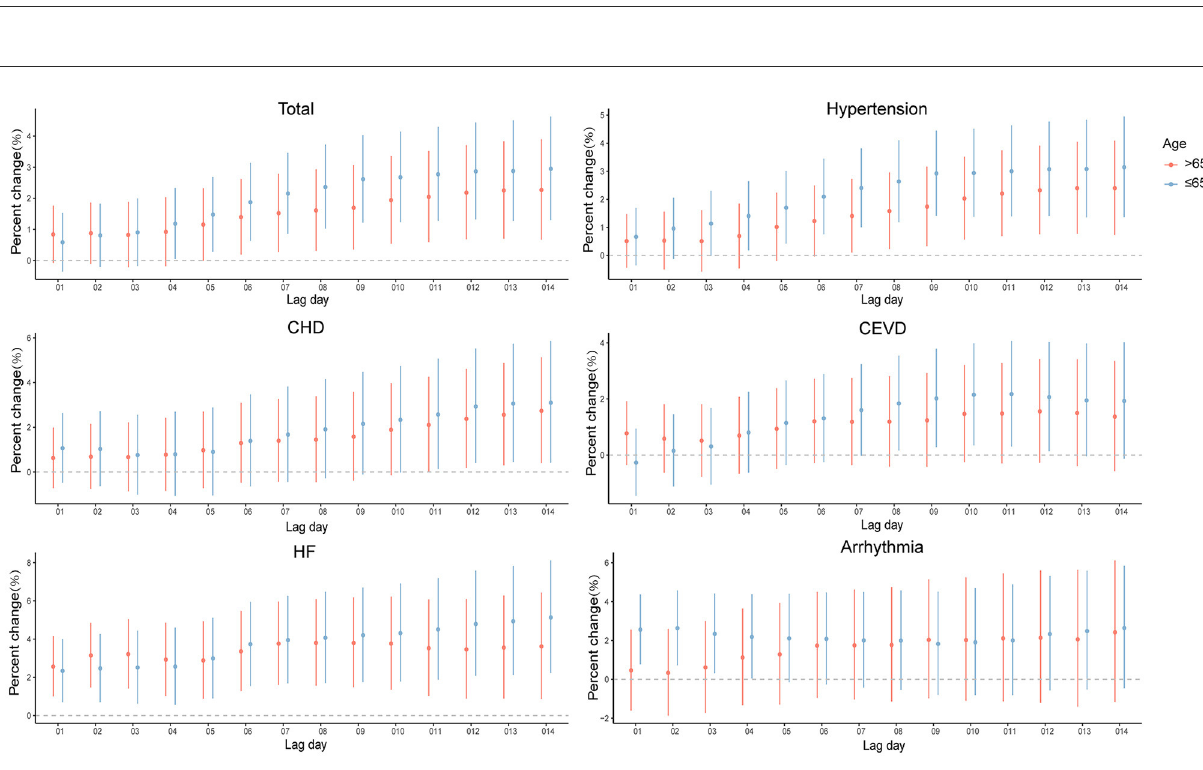
FIGURE4 Percent changes and 95% confidence intervals (CIs) of daily hospital admissions for total and cause-specific circulatory system diseases by each 10 µ g/m 3 increase of PM 2.5 concentrations stratified by age in the cumulative-day lag models. HBP, hypertension; CHD, Coronary Heart Disease; CEVD, Cerebrovascular Disease; HF, Heart